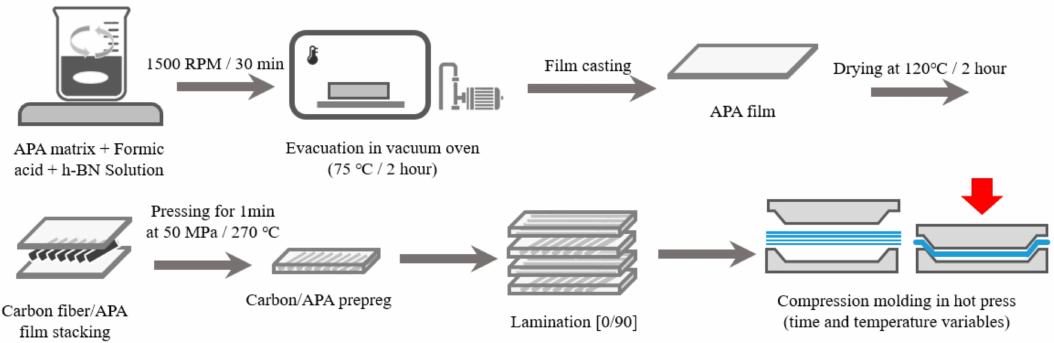
Figure 3. Schematic diagram of the Carbon/APA(h-BN) composite fabrication